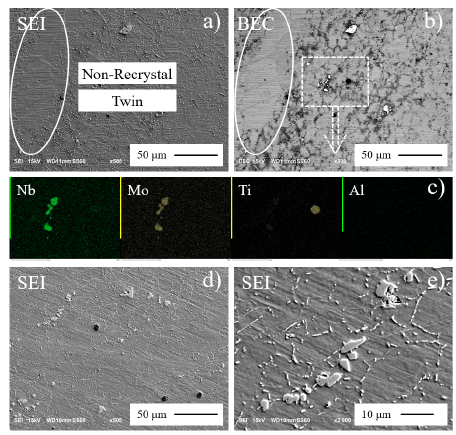
Figure 3. Scanning electron microscope (SEM) micrographs of annealed and aged Inconel 718: ( a , b ) SEM of annealed, ( c ) EDS of annealed, ( d , e ) SEM of aged